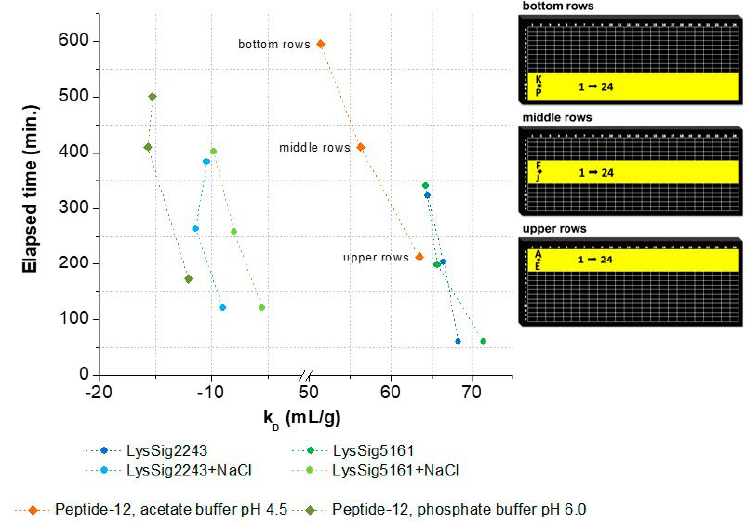
Figure 4. Variations of the coefficients of correlation ( R 2 ) as a function of the excluded outliers and number of data points for: positive k D : ( A ) LysSig2243 and ( B ) LysSig5161 and negative k D : ( C ) LysSig2243+NaCl and ( D ) LysSig5161+NaCl. An increase of R 2 (based on the excluded outliers) is indicated by stacked green bars. The table contains the plate position, run, and plate number according to Figure 1; Figure 2; number of concentration steps (2, 5, 10, and 14-mg/mL or 2, 3.5, 5, 7, 8, 10, 12, and 14-mg/mL Lysozyme); used data points for the k D analysis; and number of detected outliers by the Grubbs’ test. Corresponding k D values are shown as blue spheres on the secondary y -axis. Error bars represent the deviation compared to the overall average k D collected for all runs and plates.